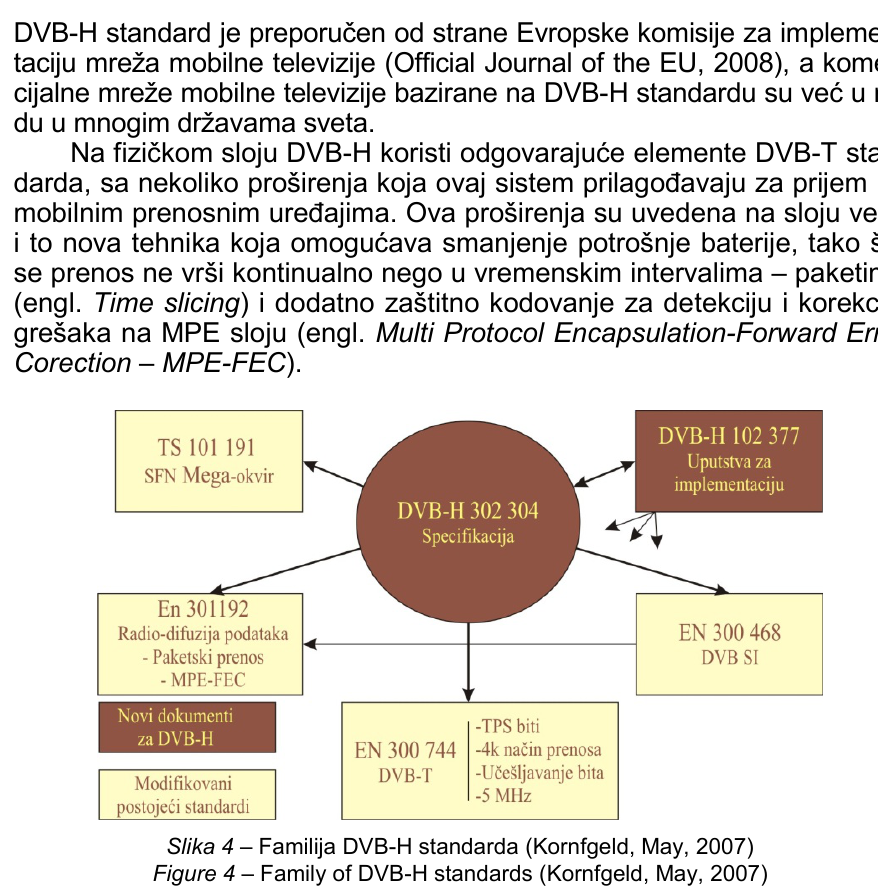
Figure 4 – Family of DVB-H standards (Kornfgeld, May,